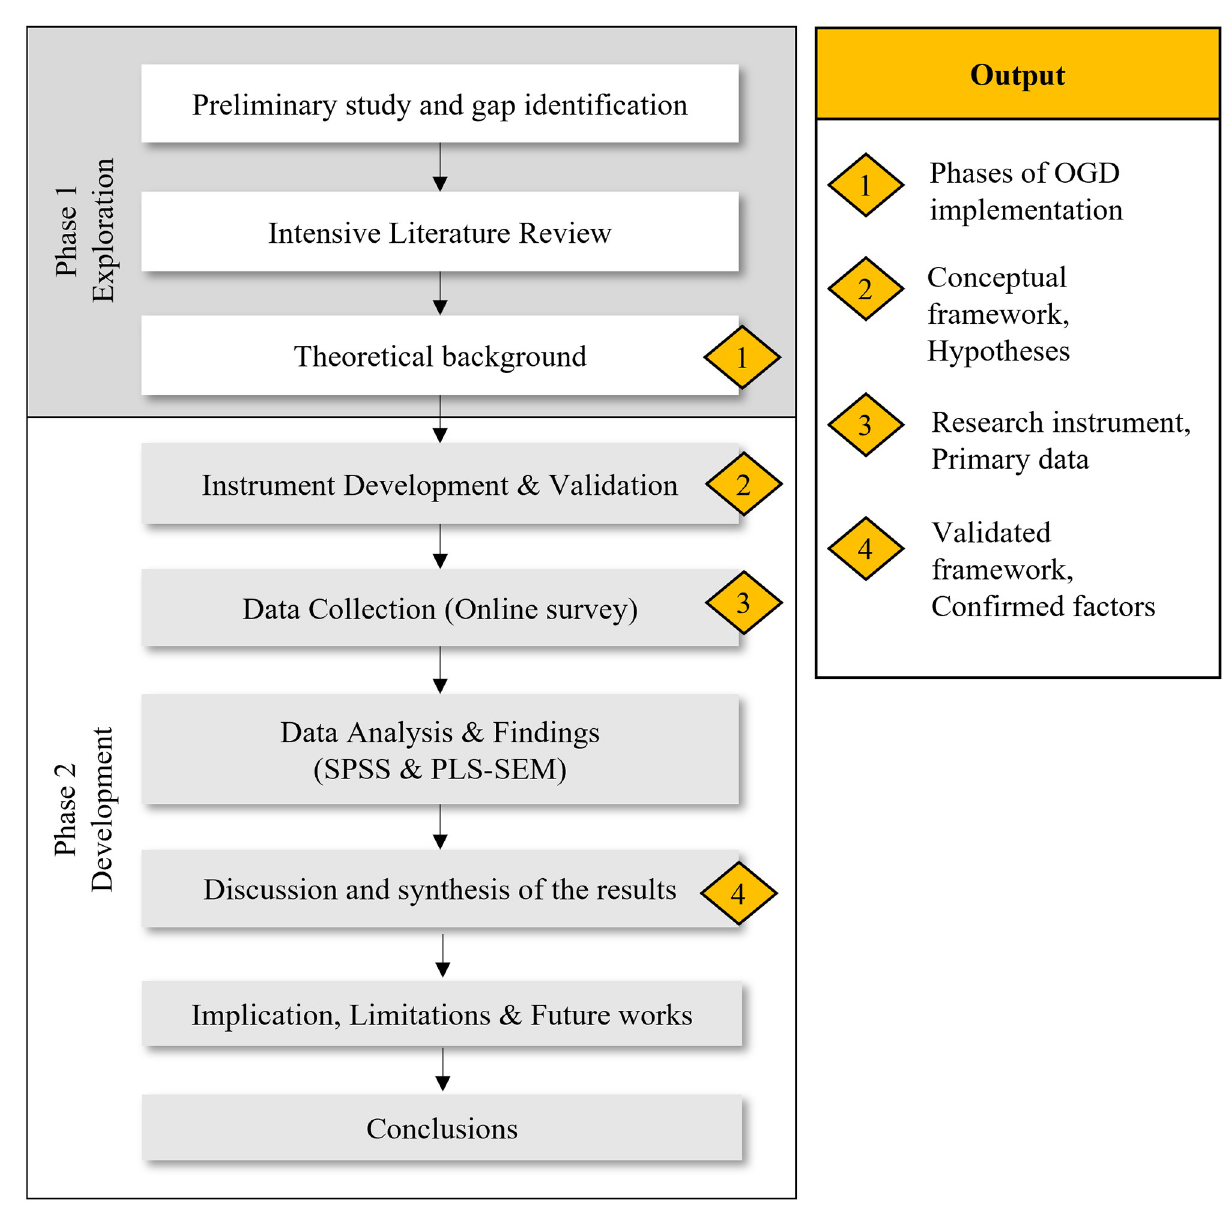
Fig 2. Research framework (Source: Own